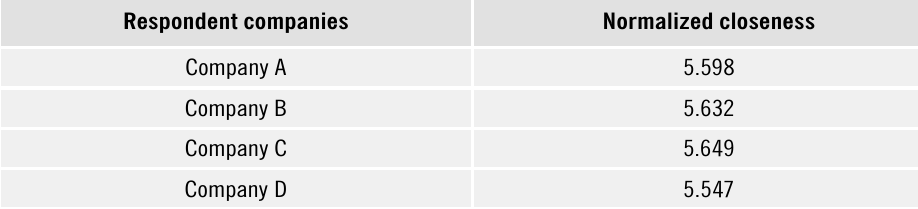
Table 8. Normalized closeness parameters of the respondent companies with unweighted